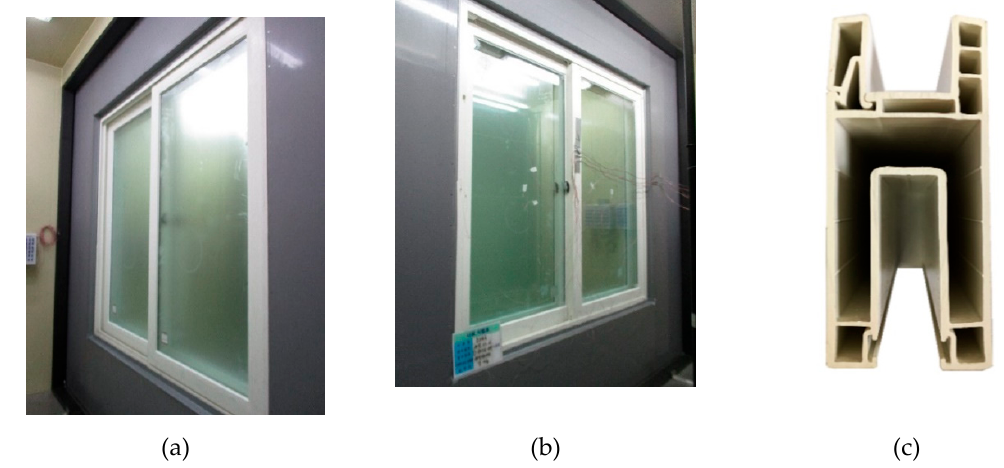
Figure 11. Window mock-up: ( a ) cold box side; ( b ) hot box side; ( c ) frame with extended height. Table 11. Boundary conditions for the TDR test in accordance with KS F 2295.